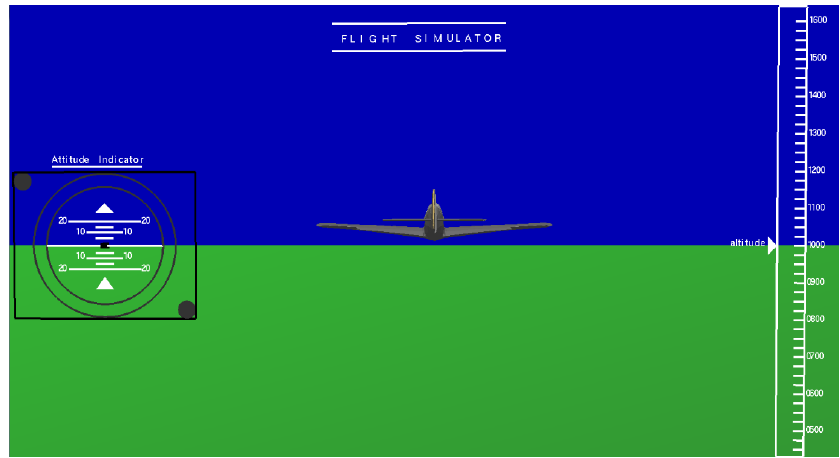
Figure 4. Graphical user interface of the proposed simulation system.